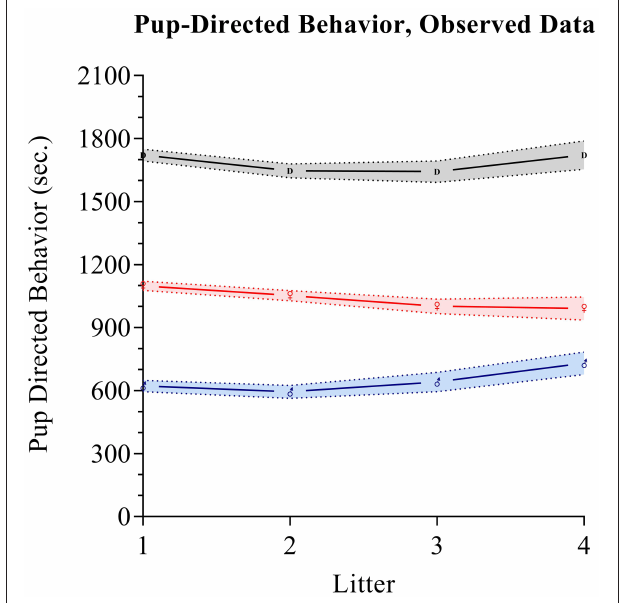
FIGURE 2 | Parental care observed data. Pup directed behaviors are tracked for fathers (blue), mothers (red), and as a dyadic composite (black) across the first four litters. Mean values for each group at each time are respectively indicated by the Mars symbol ( ♂ ), Venus symbol ( ♀ ), or a “D”. The shading in blue, red, and gray respectively indicates standard error intervals around the